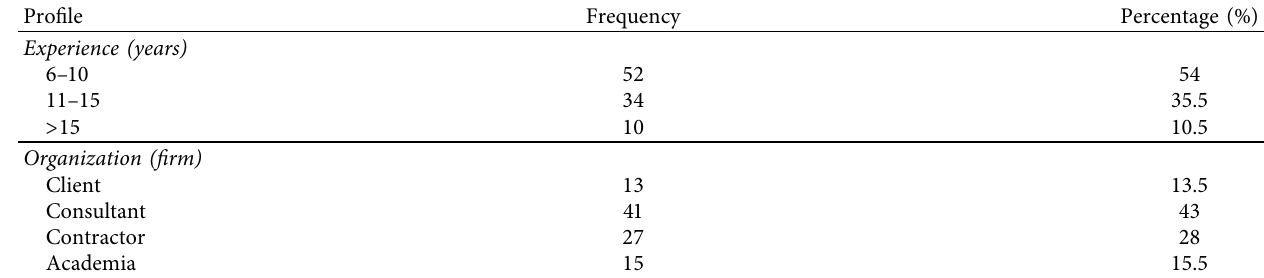
Table 3: Demography of